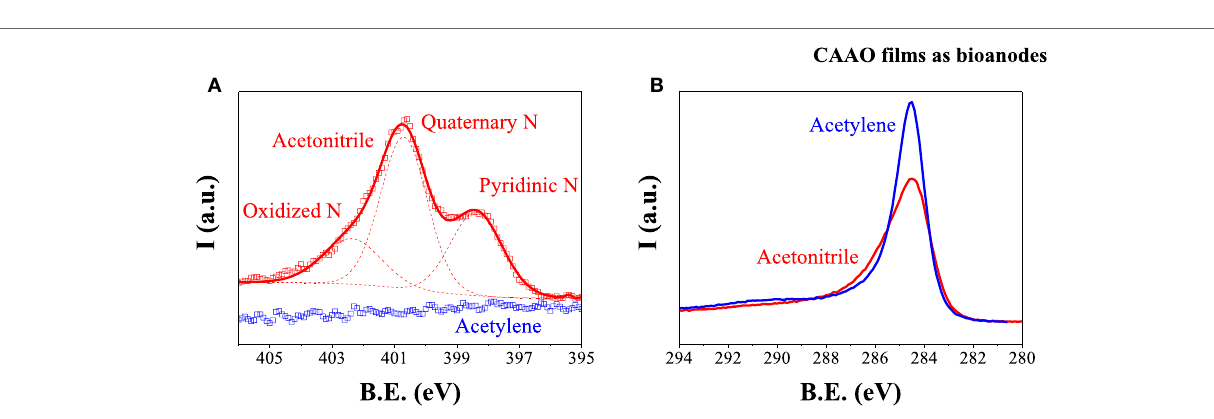
FigUre 3 | XPs n 1s (a) and c 1s (B) spectra of n-doped (red) and non-doped (blue) caaO films .